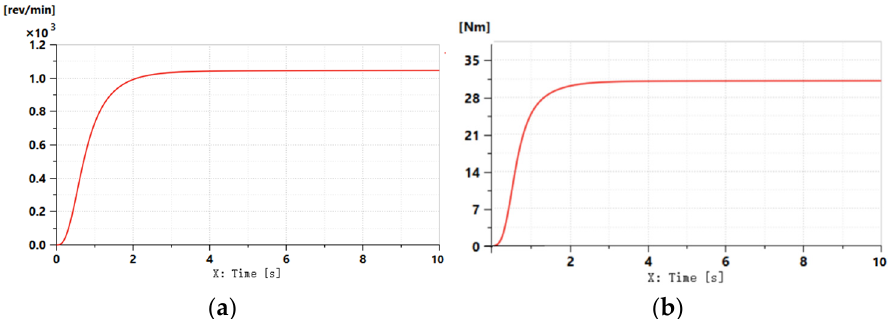
Figure 5. Hydraulic system schematic diagram: ( a ) hydraulic motor speed and ( b ) hydraulic motor torque.